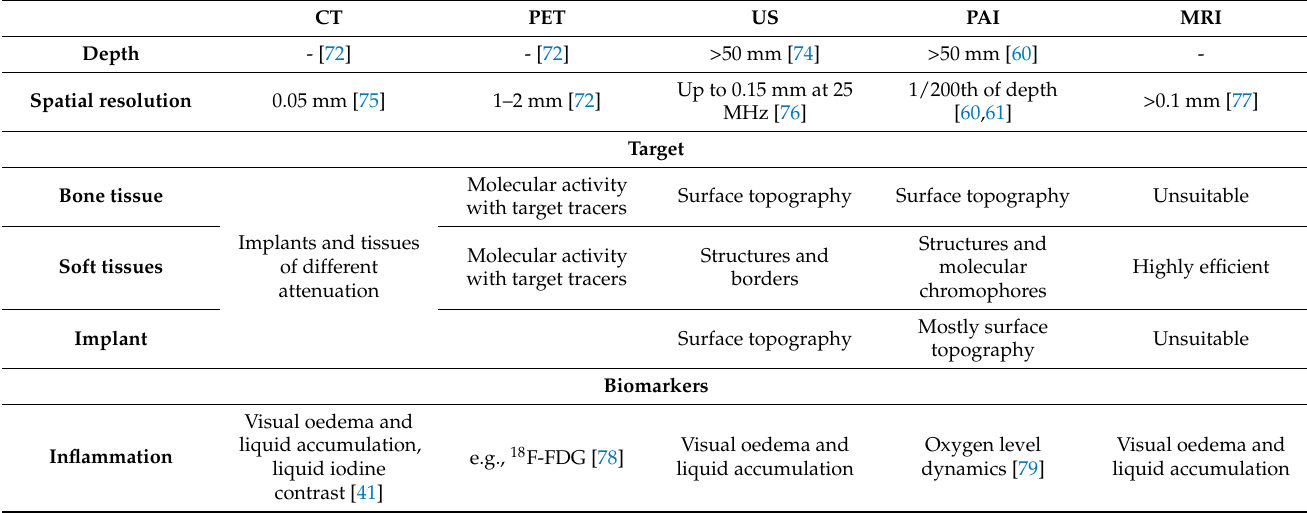
Table 4. Preclinical imaging modalities, their properties and application in relation to biodegradable implants. CT PET US PAI MRI Depth Spatial